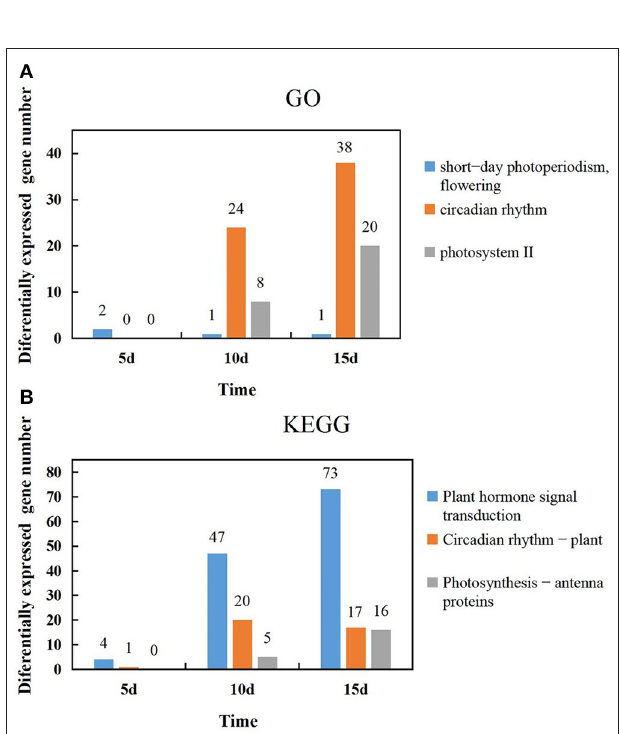
FIGURE 4 | i.e., the pvalue was becoming smaller with the significant degree of enrichment becoming greater ranging from purple to red. (D–F) Heat map clustering analysis of differential genes in plant hormone signaling pathways, circadian rhythms and antenna protein metabolism pathways. The color scale represents the values of lg FPKM (FPKM–Fragments Per Kilobase of transcript per Million fragments mapped.